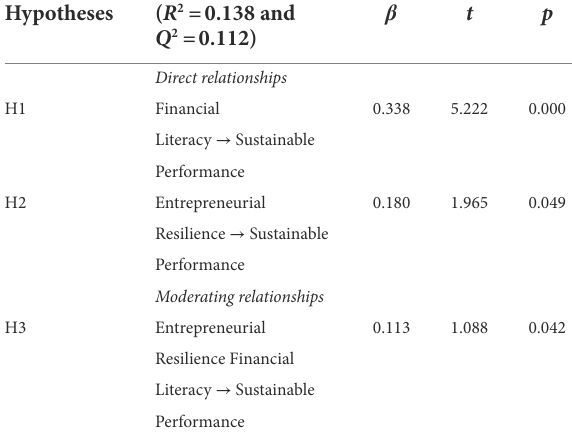
TABLE 3 Structural